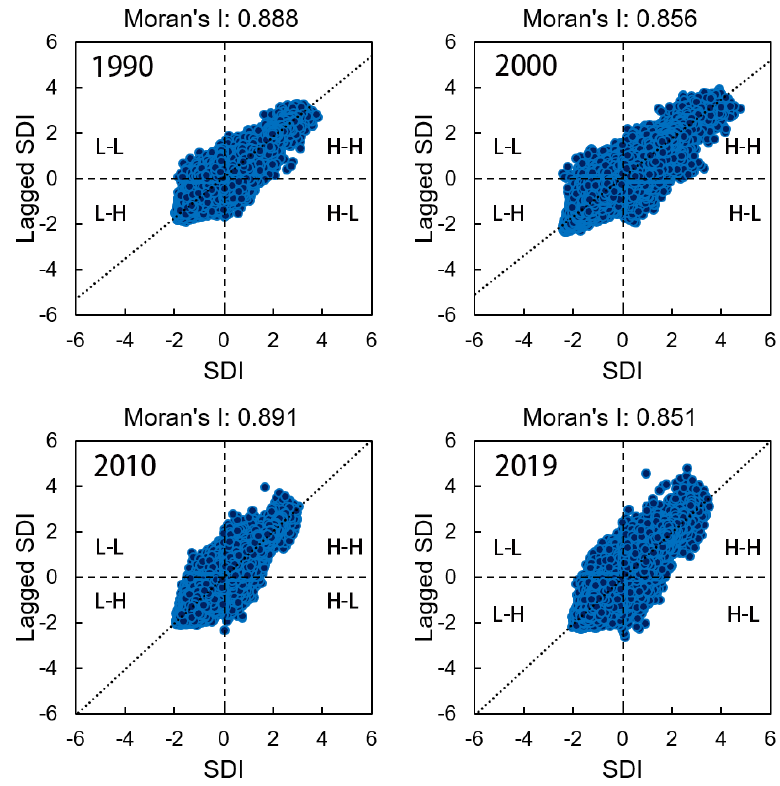
Figure 7. Moran scatter plot of the SDI in the ADD for each study year.